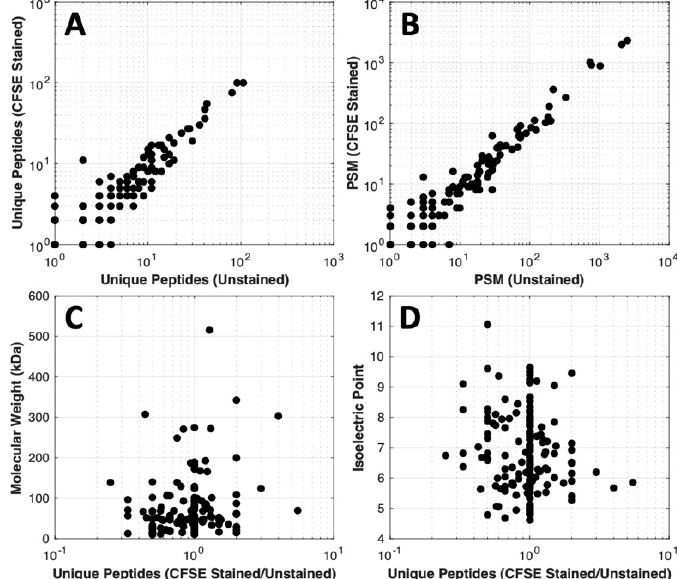
Figure 4. Mass spectrometry data comparison of CFSE stained and unstained samples. Proteins were in-gel trypsin digested and analyzed by tandem mass spectrometry. Scatter diagrams. ( A ) The number of unique peptides detected per protein from stained vs. unstained samples; ( B ) Ratio of unique peptides in the CFSE stained over unstained vs. molecular weight; ( C ) Number of peptide spectra matches per protein in the stained vs. unstained samples; ( D ) Ratio of unique peptides in the CFSE stained over unstained vs. isoelectric point.